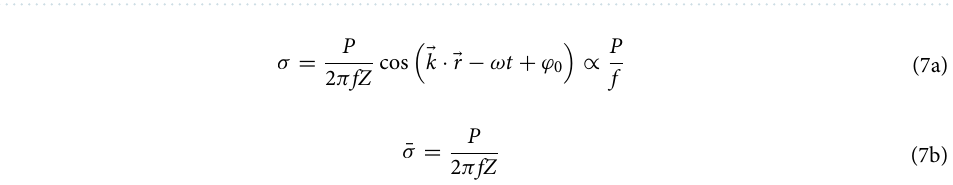
Figure 8. Comparison of the displacements of flame, speaker membrane, and air molecule at the sound frequency of ( a ) 50 Hz and ( b ) 70